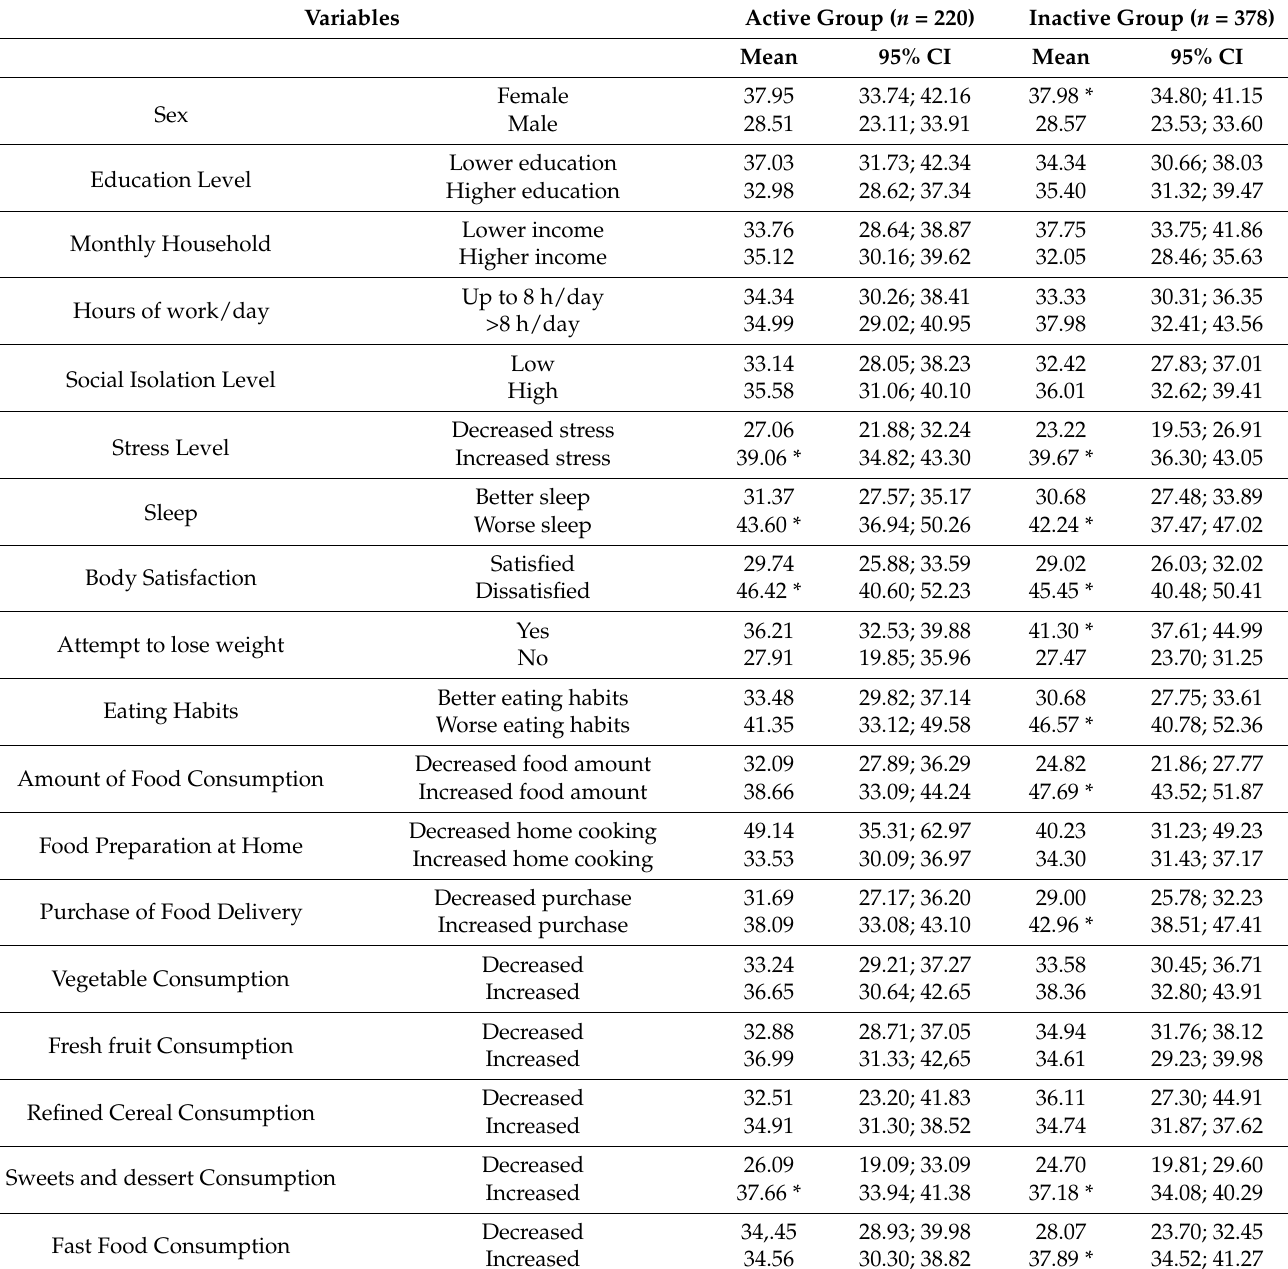
Table 2. Descriptive analysis of EE values for independent variables by level of physical activity, Brazil,